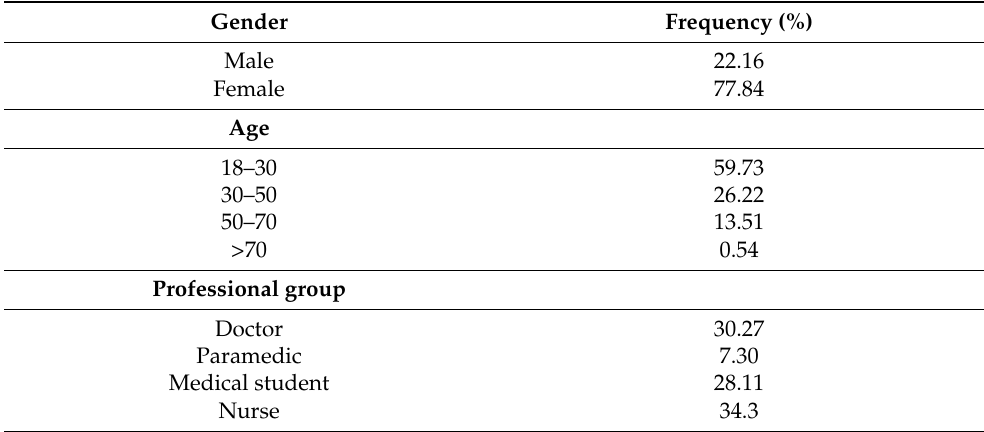
Table 1. Distribution of socio-demographic characteristics of the first group.